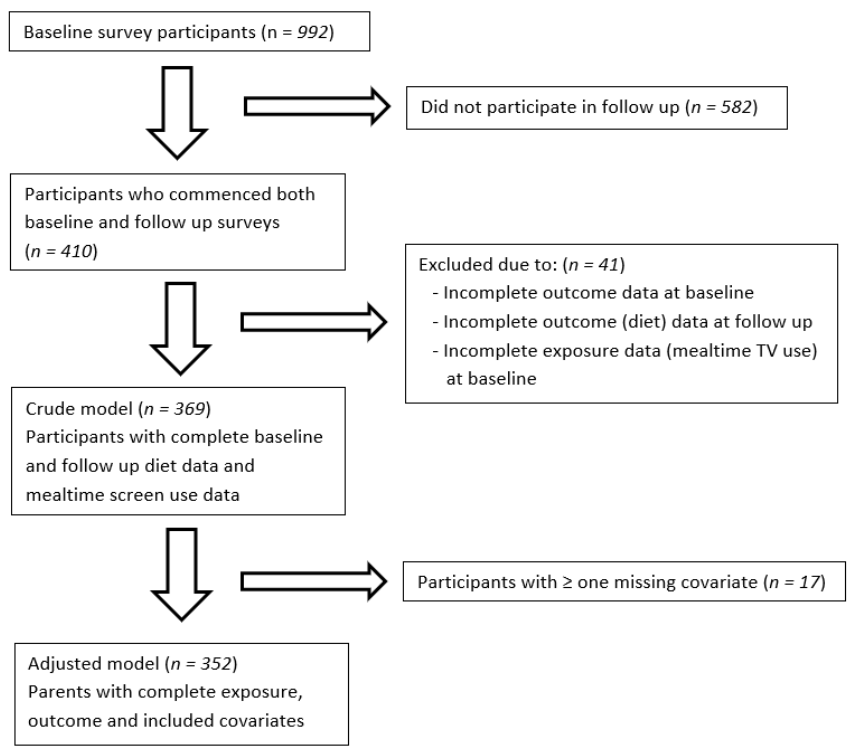
Figure 1. Participant study inclusion criteria. Covariates in adjusted models include location of meals, family meal frequency, parent education, and child age and gender. TV: Television.